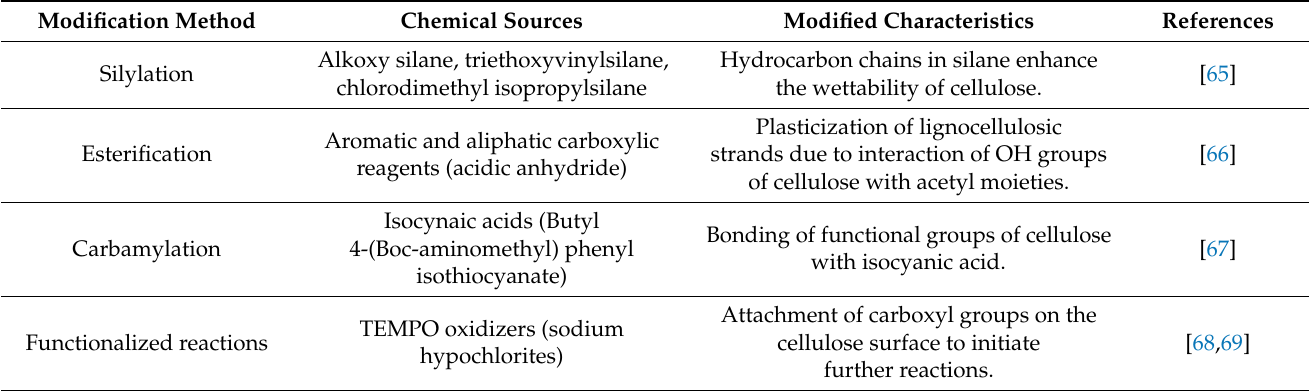
Table 3. Nanocellulose treatment methods and